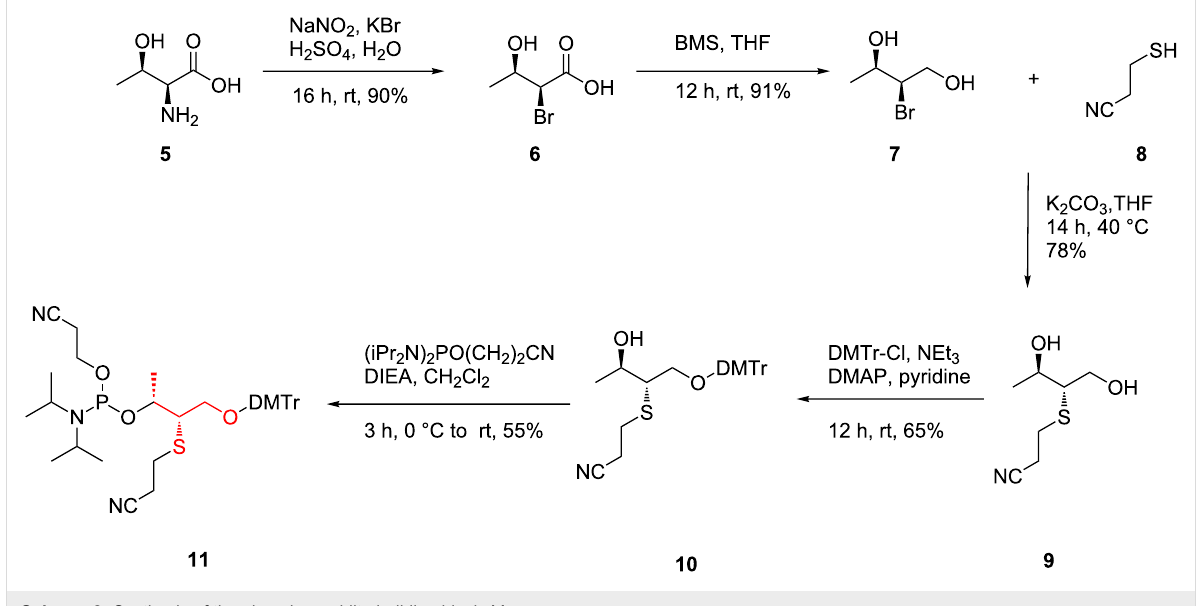
Scheme 2: Synthesis of the phosphoramidite building block 11 .